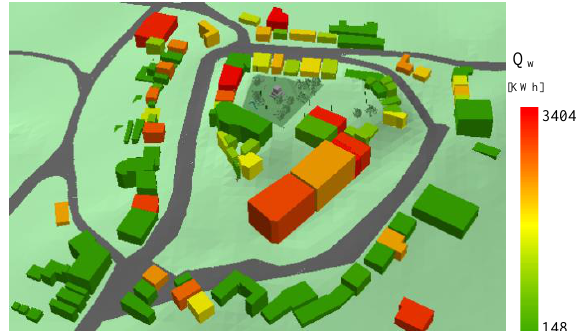
Figure 17. Energy demand for domestic hot water production